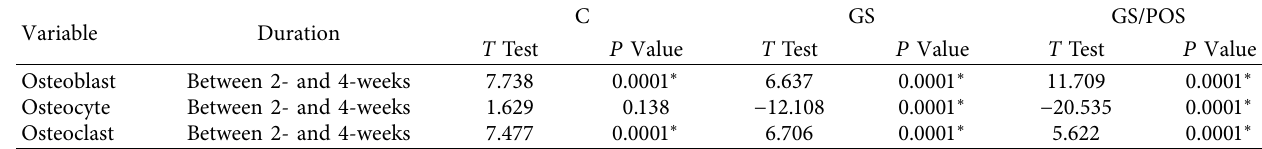
Table 1: Duration comparison of bone cells in all studied groups.